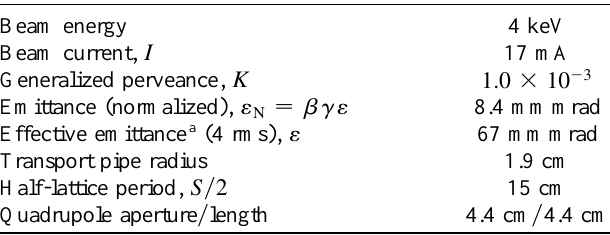
TABLE I. Beam and FODO lattice